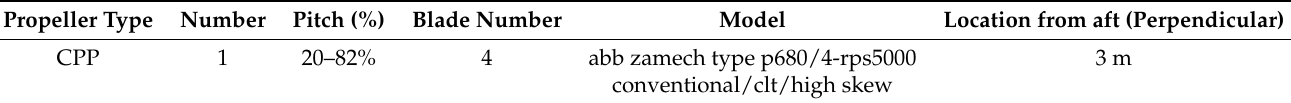
Table 2. The parameters of the ship’s